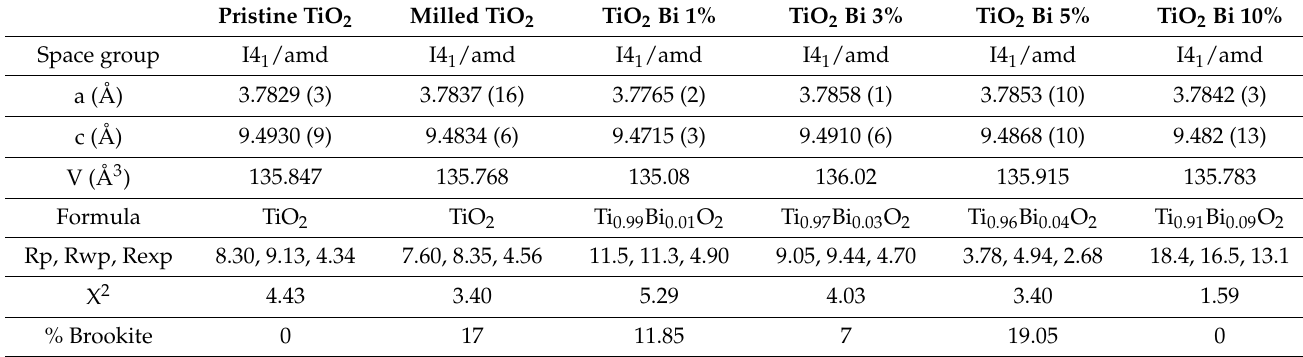
Table 2. Parameters of the anatase structure for the